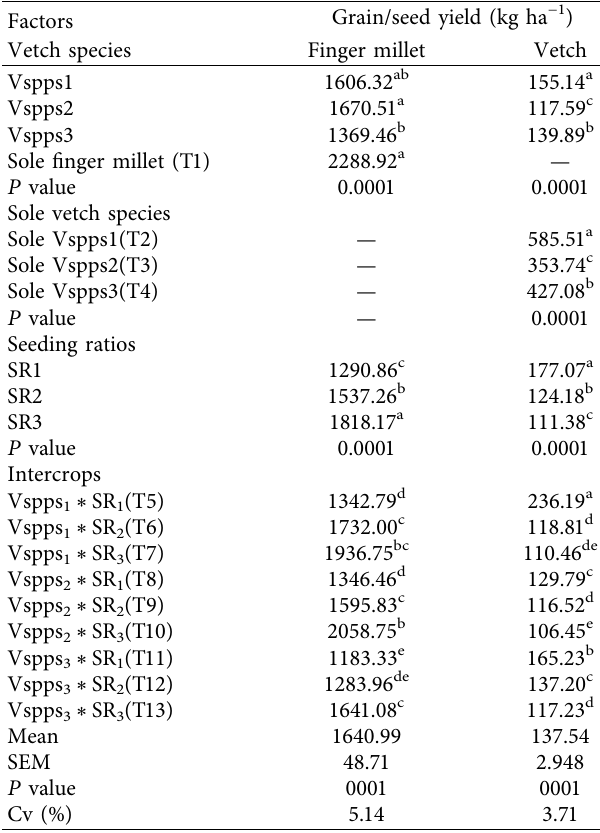
Table 4: Grain/seed yields of finger millet and vetch as affected by species, seeding ratio, and